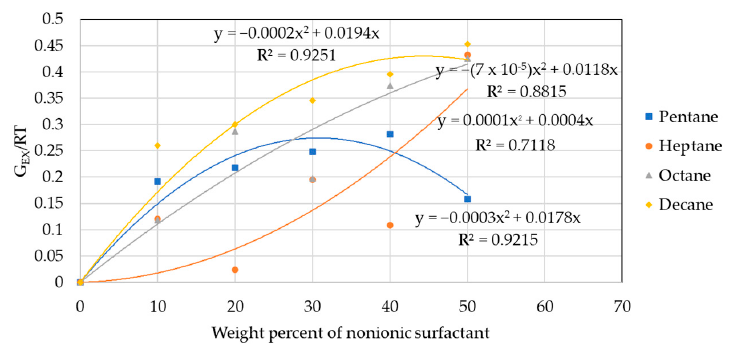
G EX values of SDHS-AAE(6EO4PO) values of SDHS-AAE(6EO4PO) systems. Figure 6. The RT RT